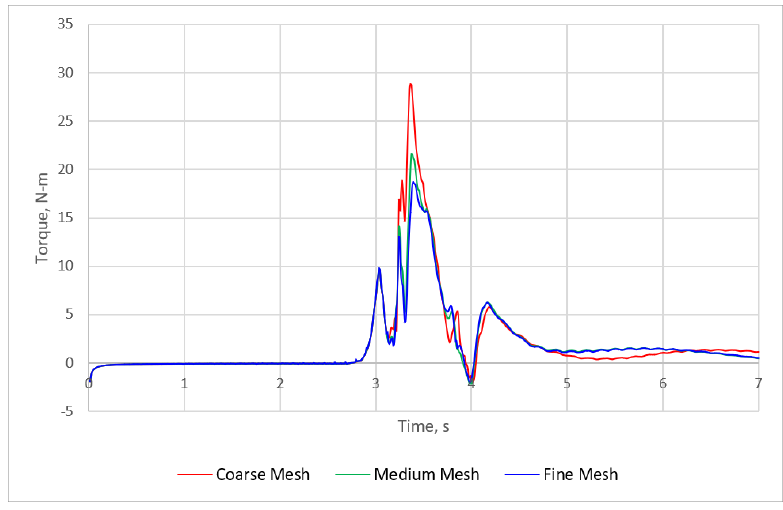
Figure 10. Torque vs. time curve at ω = 2 rad/s for difference mesh densities.